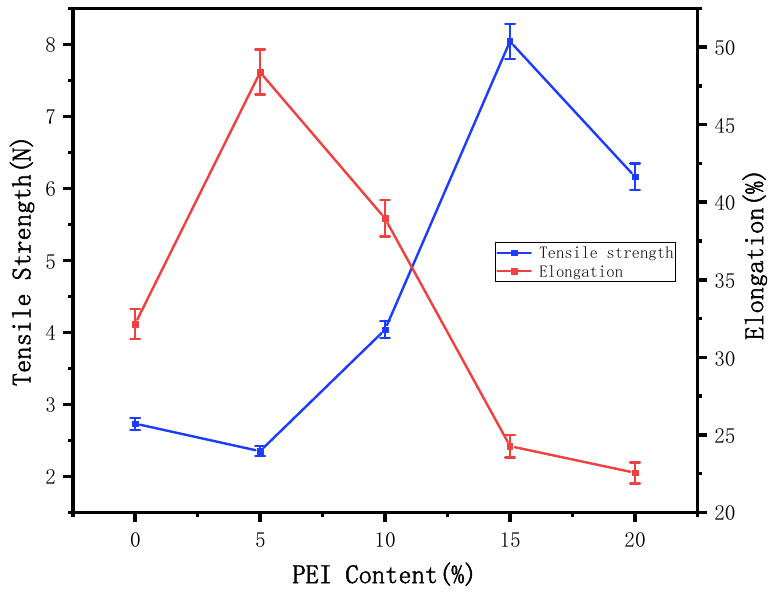
Figure 8. Effects of PEI content on tensile strength and elongation of membrane.